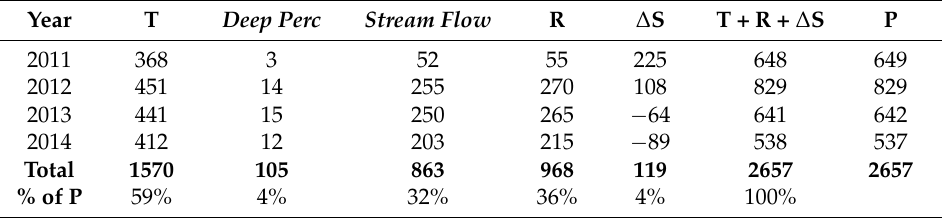
Table 4. Components (mm ¨ y ´ 1 ) of the water balance at the study area. T: transpiration; R: total runoff (including deep percolation and stream flow); ∆ S: change of soil water storage; P: